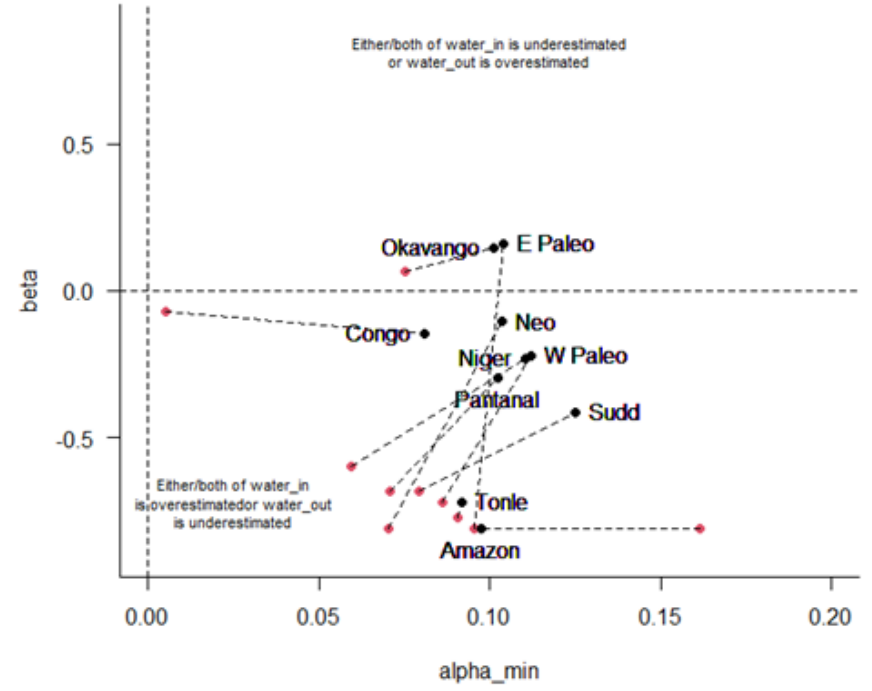
Figure 7. Summary of plots in Fig. 6. Optimal values of β and α min are shown (referred to as β opt and α min opt in the text), calculated as the centroids of the maximal region on the KGE plots (black) or NSE plots (red) for each site (with α max = 1 . 0) from Fig. 6. On this plot, we define water in = (channel + surface + subsurface inflow + precipitation) and water out = (infiltration + evaporation). Note that clear maxima were not present for all case studies for NSE (Fig. 6), but when present they are shown connected to the equivalent maxima for